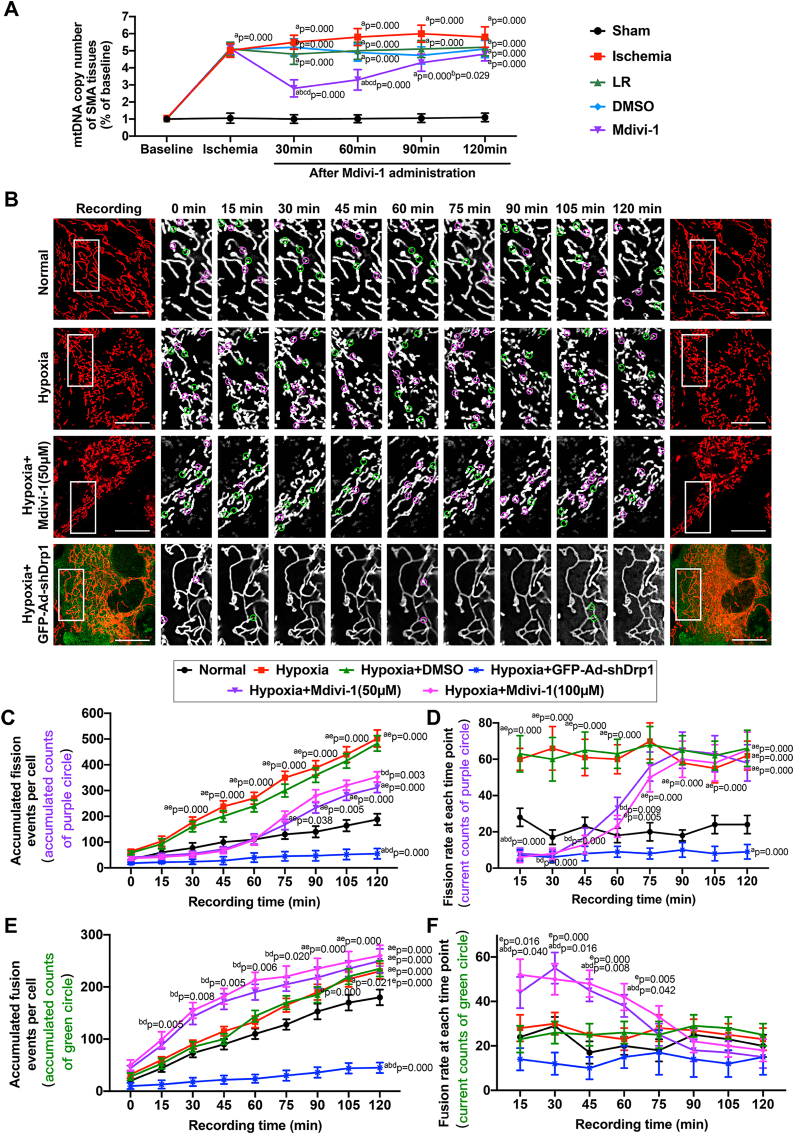
Effects of Mdivi-1 on mitochondria dynamics in ischemic/hypoxic injury. (A) mtDNA copy number in vascular tissues (n = 8 rats/time point in each group). (B) Time-lapse recording of mitochondrial dynamics, including fission and fusion events, for 120min (15min interval). Mitochondrial fission sites were circled in purple and mitochondrial fusion sites were circled in green (bar = 25 μm). (C–D) Accumulated fission events (C) and real-time fission rate (D) per cell after Mdivi-1 administration at concentration of 50 and 100 μM in hypoxic VSMCs (n = 16 cells/group). (E–F) Accumulated fusion events (E) and real-time fusion rate (F) per cell after Mdivi-1 administration at concentration of 50 and 100 μM in hypoxic VSMCs (n = 16 cells/group). a: P < 0.05 compared with Sham or Normal group at the same time point, b: P < 0.05 compared with Ischemia or Hypoxia group at the same time point, c: P < 0.05 compared with the LR group at the same time point, d: P < 0.05 compared with the DMSO or Hypoxia + DMSO group at the same time point, e: P < 0.05 compared with the Hypoxia + GFP-Ad-shDrp1 group at the same time point. (For interpretation of the references to colour in this figure legend, the reader is referred to the Web version of this article.)